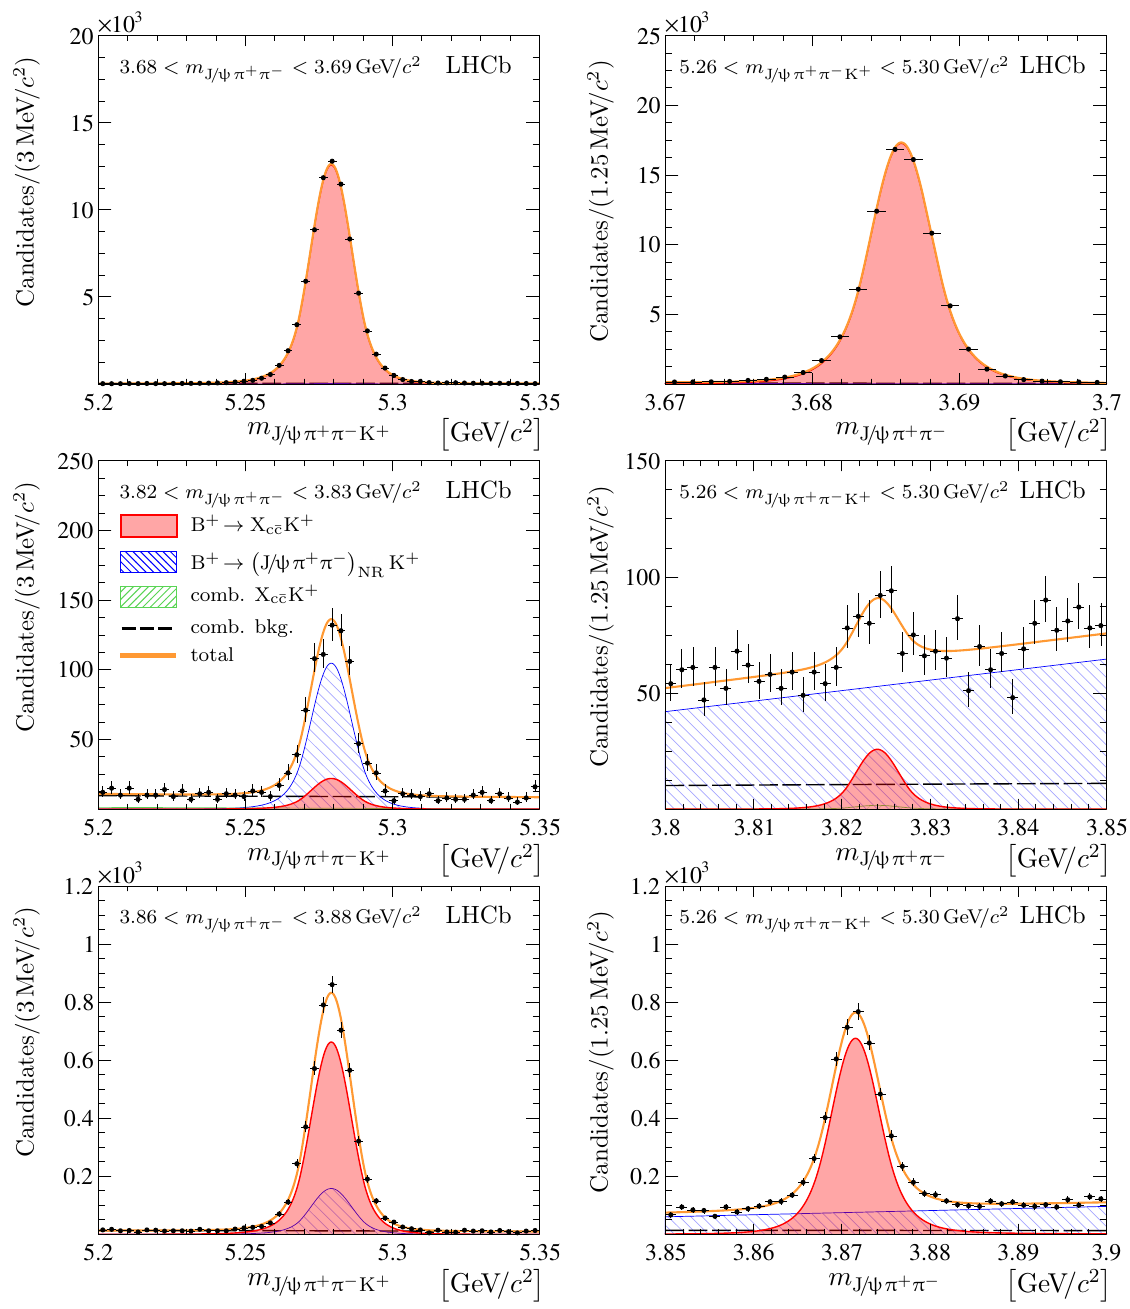
Figure 2 . Distributions of the (left) J = (cid:25) + (cid:25) (cid:0) K + and (right) J = (cid:25) + (cid:25) (cid:0) mass for selected (top) B + ! (2S)K + , (middle) B + ! 2 (3823)K + and (bottom) B + ! (cid:31) c1 (3872)K + candidates shown as points with error bars. A (cid:12)t, described in the text, is overlaid.